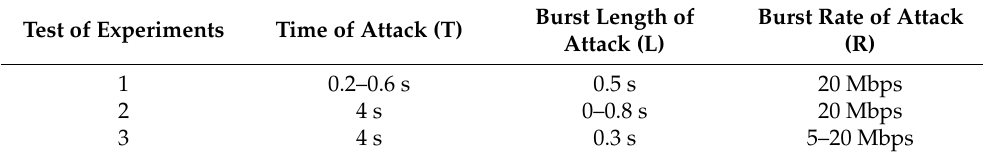
Table 1. Attack parameters in NS-2.